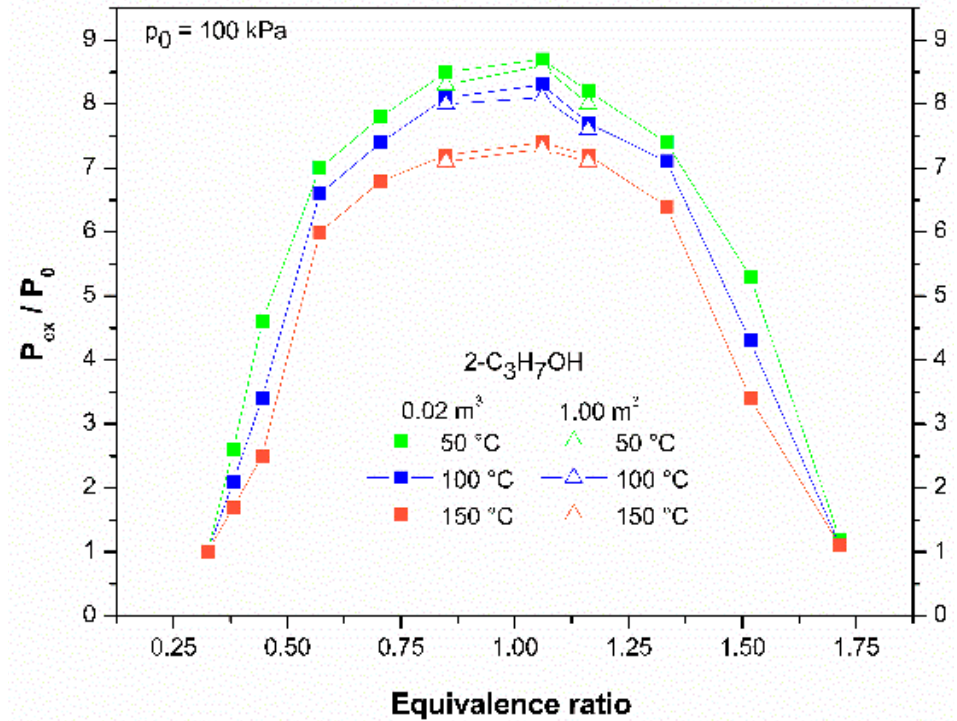
Figure 6. p ex /p 0 versus Φ = 0.3–1.7 for 2-propanol–air mixtures at various initial volumes, Figure 6. p ex / p 0 versus Φ = 0.3–1.7 for 2-propanol–air mixtures at various initial volumes, temperatures, temperatures, and mixture compositions, p 0 = 100 kPa. and mixture compositions, p 0 = 100